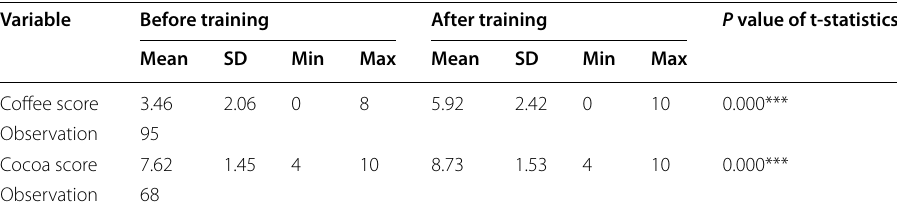
Table 5 Summary statistics of the outcome variable (test